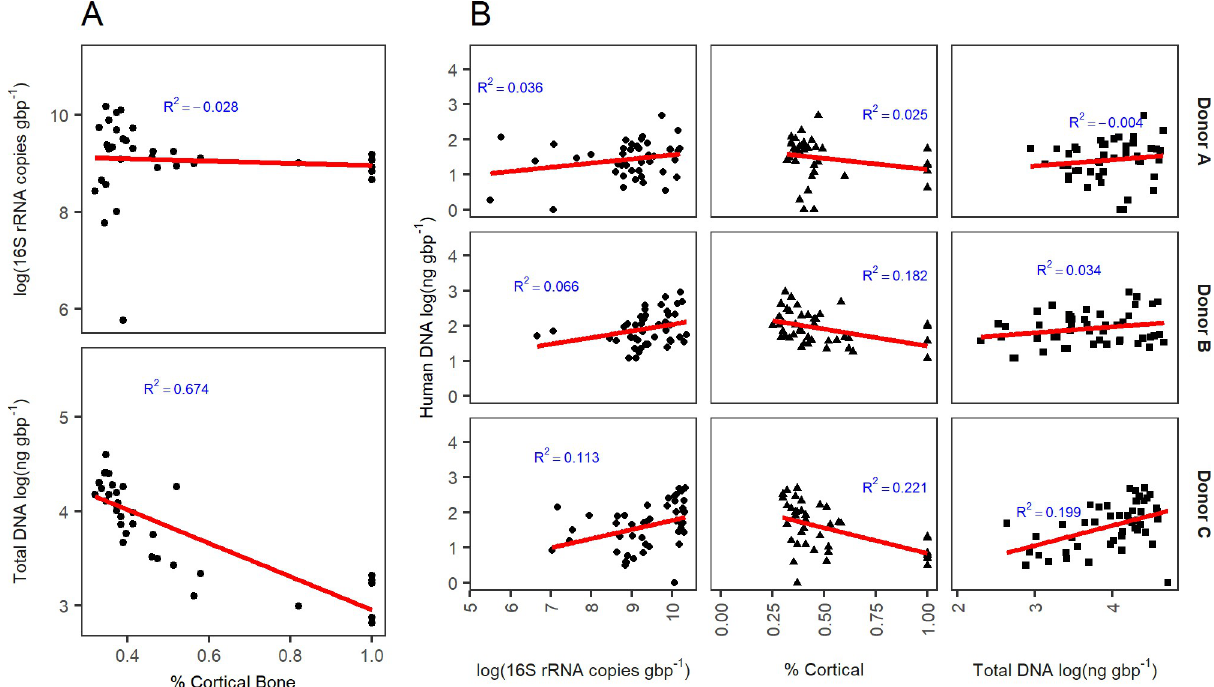
Fig 2. (A) Percent cortical content compared with log-normalized bacterial gene abundances and log-normalized total DNA, averaged by bone type (n = 3). (B) Bacterial gene abundances, percent cortical content, and total DNA compared with human DNA concentrations by individual (A, B, C). Raw data are shown. The red line demonstrates the best fit linear